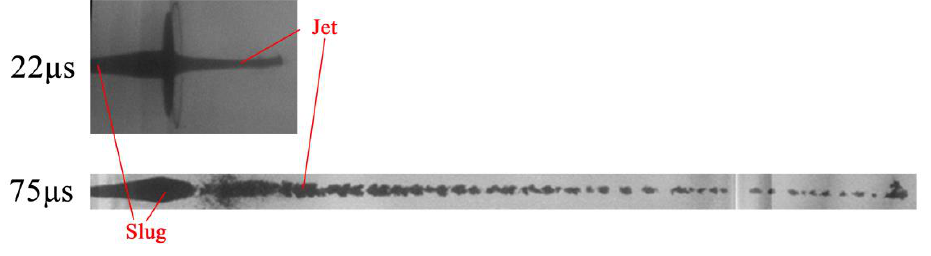
Figure 15. The X-ray image of Mo-10Ta jet.